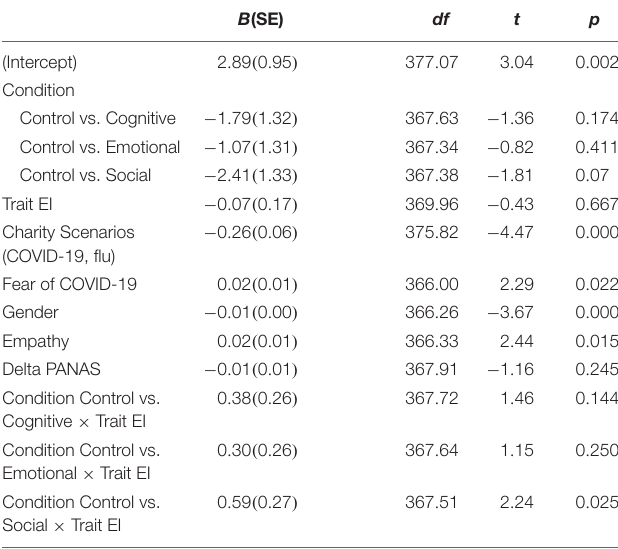
TABLE 4 | Multilevel linear regression model with willingness to help as the dependent variable, type of stress and target of the donation as well as the interaction between type of stress and trait EI.